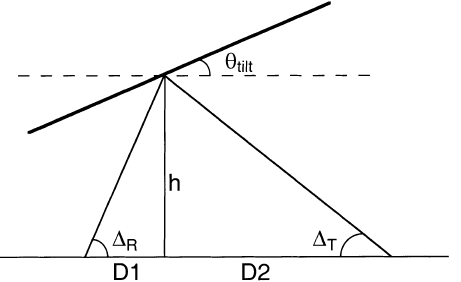
Fig. 1. Schematic of an idealised ionospheric ‘tilting’